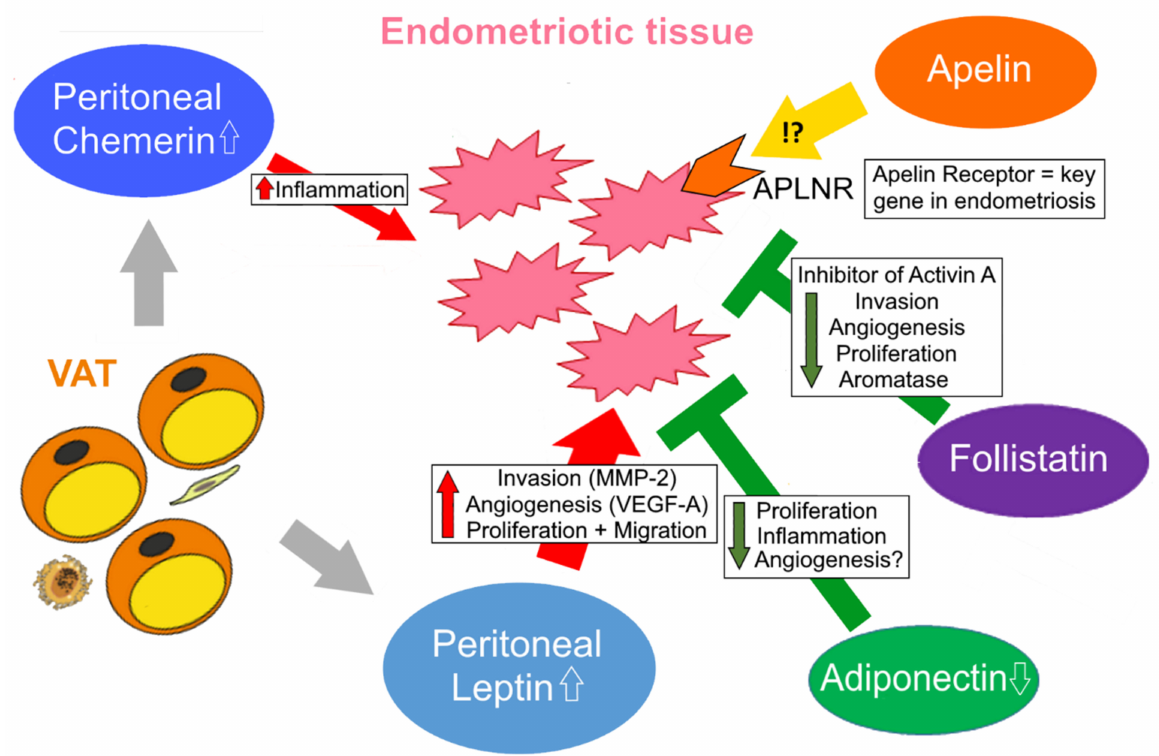
Figure 2. Proposed effect of the indicated adipokines on endometriotic tissue based on the current state of research. Additional studies are necessary to further substantiate the role of these adipokines in endometriosis. It can be expected that the recent report suggesting apelin receptor APLNR to be one of three key genes in endometriosis resulting from in silico analyses of DNA microarray data will encourage functional studies to elucidate underlying molecular mechanisms. Red arrows indicate adverse effects on endometriosis; green inhibitor arrows indicate beneficial effects. In text boxes, red arrows indicate the up-regulation and green ones the down-regulation of the respective pathways. White arrows indicate an increase or decline in the adipokine concentration in the blood/peritoneal fluid of women with